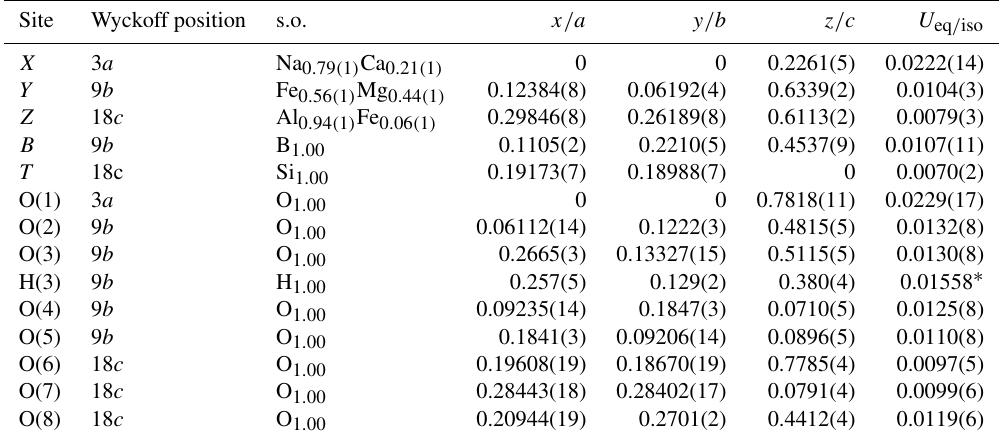
Table 5. Sites, Wyckoff positions, site occupancies (s.o.), fractional atom coordinates, and isotropic ( ∗ ) or equivalent isotropic displacement parameters (in Å 2 ) for